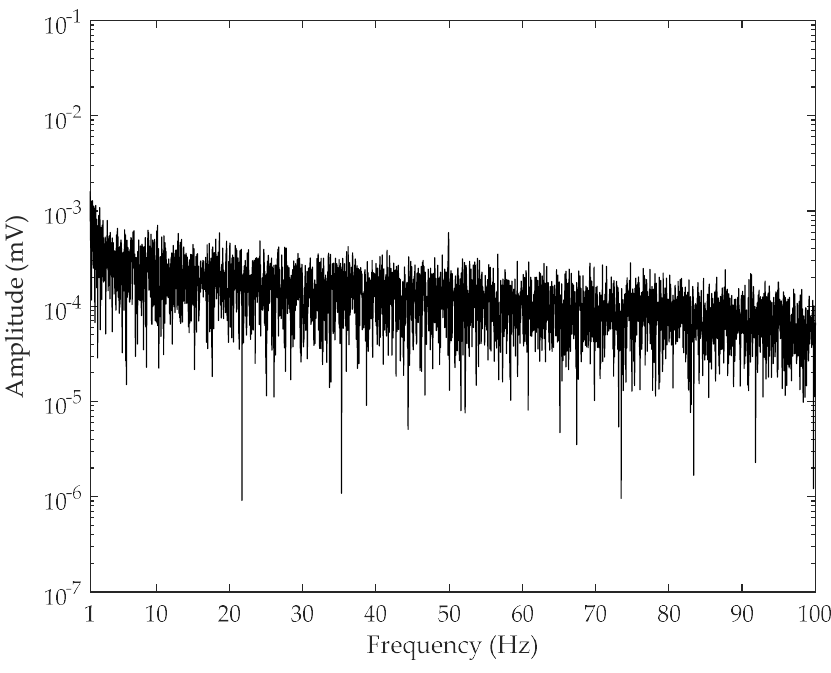
Figure 9. The input referred voltage noise in frequency domain.